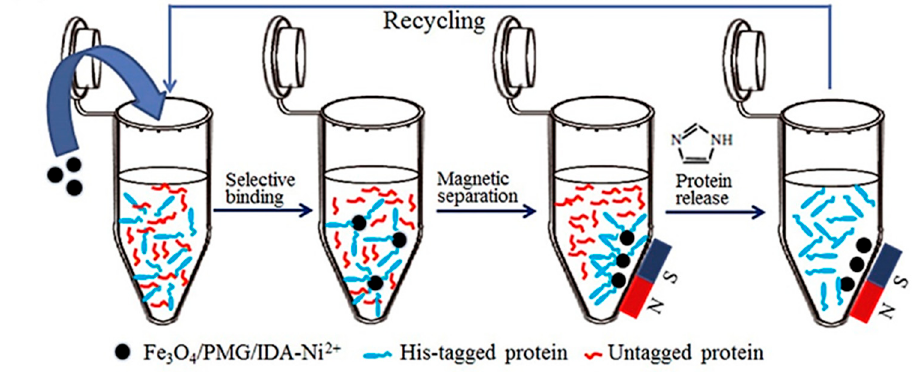
Figure 18. A simplified example of magnetic protein separation using functionalized-magnetic beads in a single tube. (Re-printed from Zhou et al. [142]. Copyright (2018), with permission from Elsevier).